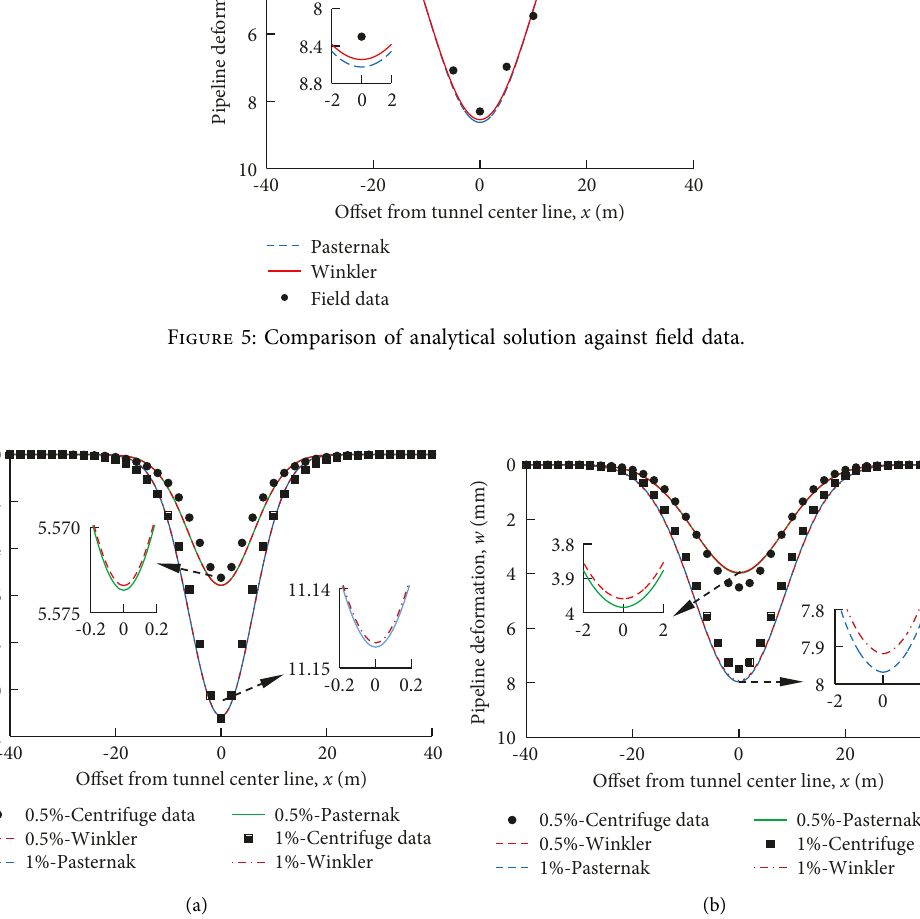
Figure 6: Comparison of analytical solution against centrifuge test data. (a) Small stiffness pipeline and (b) large stiffness